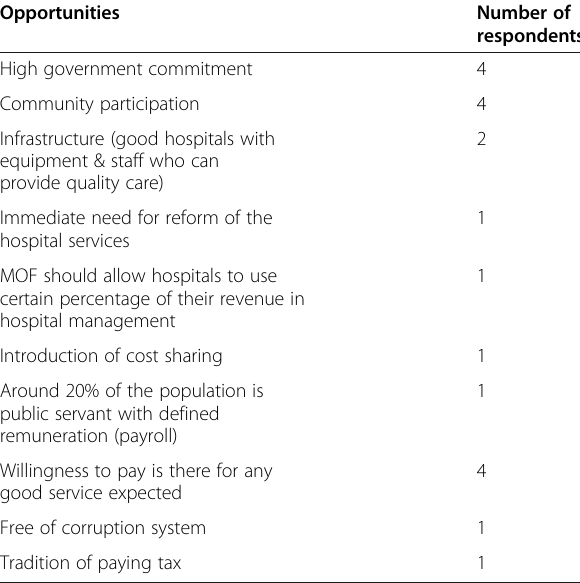
Table 1 The key health financing related challenges Challenges